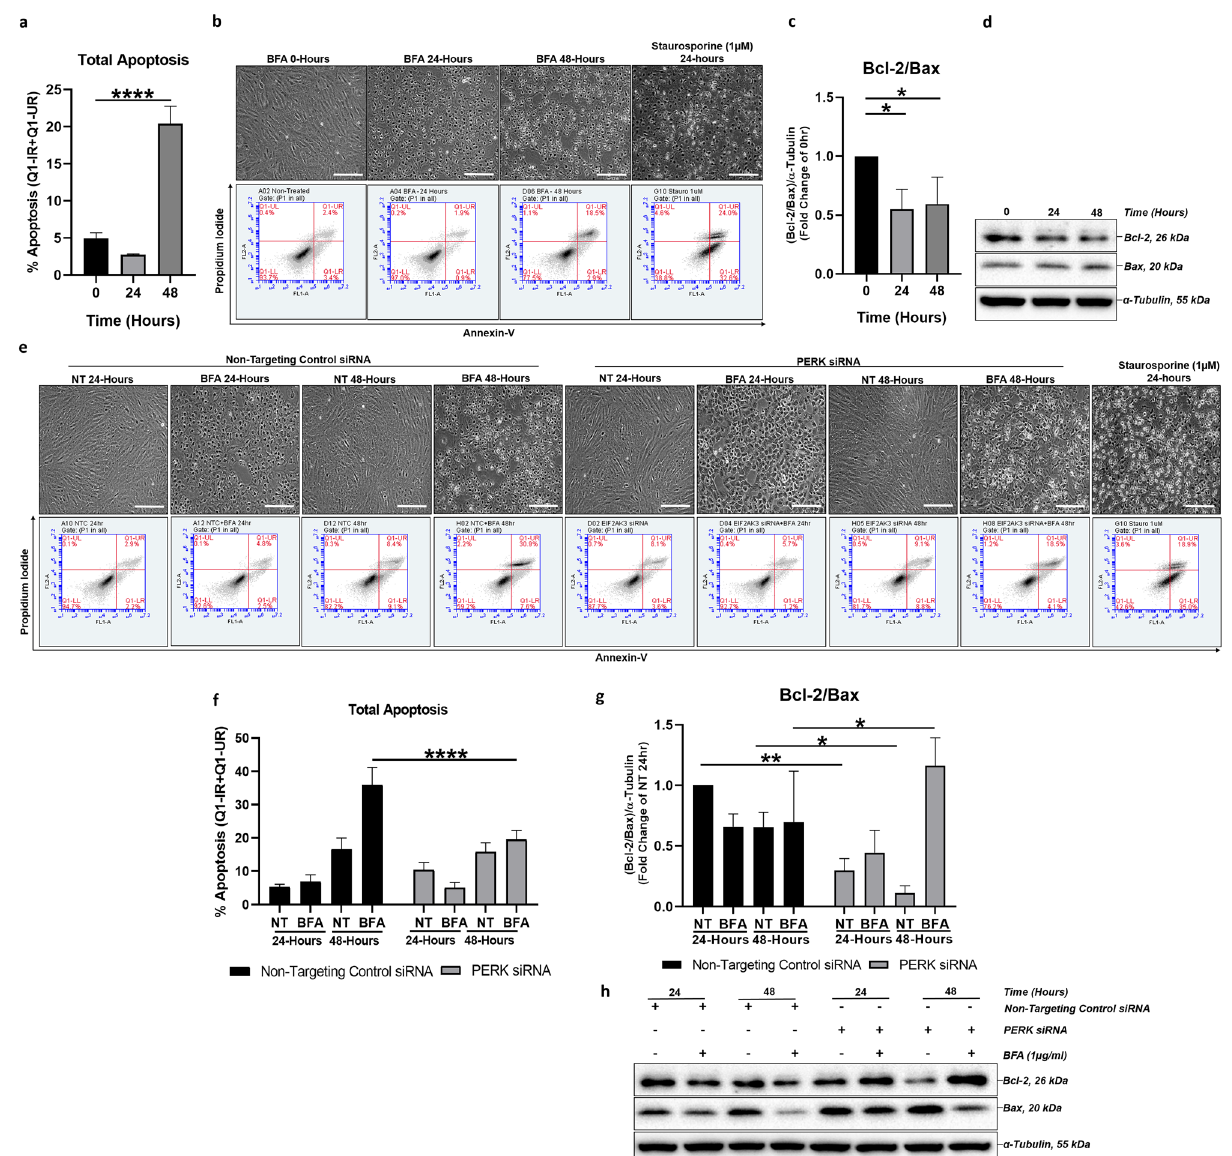
Figure 2. PERK downregulation impairs ER-stress induced apoptosis in a Bax/Bcl-2-dependent manner. Apoptosis associated with BFA-induced ER stress is mediated via PERK pathway signalling and involves downregulation of the Bcl-2/Bax ratio in ARPE-19 cells. Following PERK knockdown, ER stress-induced apoptosis is downregulated and associated with an increase in the Bcl-2/Bax ratio in ARPE-19 cells. Apoptosis of ARPE-19 cells treated with 1 μg/ ml BFA for 0–48 h was analysed by flow cytometry using 1 μM Staurosporine as a positive control and Annexin V (AV) and Propidium Iodide (PI) as markers of early-stage and late-stage apoptosis, respectively. Total apoptosis was determined by combining the percentage of cells detected in the respective quadrants (lower right and upper right). Significantly increased ER stress-induced total apoptosis was determined by 48 h ( a , b ). Light microscopy showed ARPE-19 cells with apoptotic morphology by 24 h with large regions lacking adherent cells present by 48 h ( b -top row). Under the same conditions, ARPE-19 cells showed significant decrease of the Bcl-2/Bax (anti-apoptotic/pro- apoptotic) proteins ratio ( c ); representative immunoblots shown ( d ). Following PERK knockdown, the percentage of cells undergoing ER stress-induced apoptosis decreased significantly compared to cells transfected with non-targeting control siRNA and treated with BFA by 48-h time point ( e , f ); representative light microscopy images ( e , top row) and two parameter histogram plots with P1 gate applied ( e , bottom row) shown. 24-h 1 µM Staurosporine was used as a positive control. Furthermore, in cells transfected with PERK siRNA, the ratio of Bcl-2/Bax protein expression showed a significant increase 48-h after induction of ER stress compared to cells transfected with non-targeting control siRNA, while significant decreases were determined in non-treated groups at both 24 and 48-h time points ( g , h ), with representative immunoblots shown ( h ). Results are presented as fold-changes from 0-h time-point ( a , c ) or fold changes from the NT group in cells transfected with Non-Targeting Control siRNA at a 24 h time-point ( f , g ). Representative light microscopy images, ×10 magnification, scale bar = 250 μm. Protein levels were normalised to α-tubulin. Means ± standard deviation are shown (n = 3) . Statistical analysis was performed using either the ( a , c ) one- way ANOVA with Dunnet’s post hoc-test or ( f , g ) two-way ANOVA with Sidak’s multiple-comparison test (* p ≤